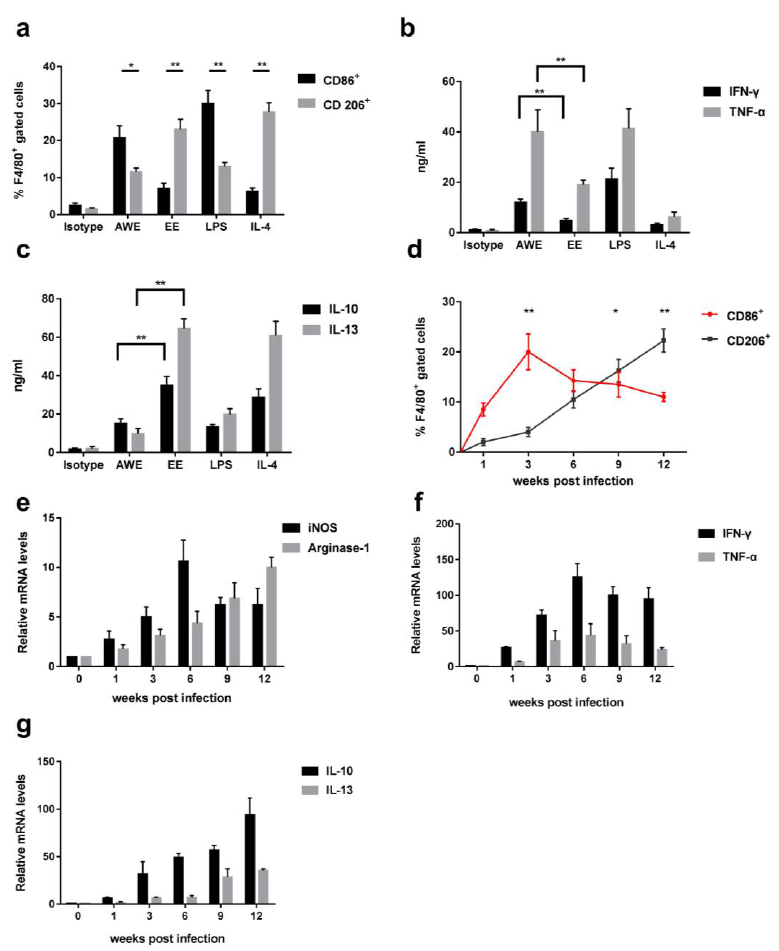
Figure 1. C. hepatica infection induced macrophage polarization in livers of infected mice: ( a ) Macrophages collected from livers of normal mice were incubated in vitro with C. hepatica AWE or EE, which induced M1 (F4/80 + CD86 + ) and M2 (F4/80 + CD206 + ) phenotypes, as measured by flow cytometry, respectively. Isotype antibody was used as negative control; LPS or IL-4 co-cultured with macrophages as M1 and M2 positive controls, respectively. ( b ) The levels of M1-related cytokines IFN- γ and TNF - α were measured in the supernatant of normal mouse hepatic macrophages incubated with AWE or EE by ELISA. ( c ) The M2-related cytokines IL-10 and IL-13 were measured in the supernatant of normal hepatic macrophages incubated with AWE and EE of C. hepatica by ELISA. ( d ) Macrophage polarization from M1 (CD86 + ) to M2 (CD206 + ) on gated F4/80 + intrahepatic macrophage cells during the natural course of C. hepatica infection in mice. ( e ) iNOS (M1) and Arginase-1 (M2) dynamic mRNA expression in macrophages collected from livers of mice infected with C. hepatica measured by RT- qPCR relative to the expression of β -actin (control gene). ( f ) M1-related IFN- γ and TNF - α dynamic mRNA exp ression in the intrahepatic macrophages from C. hepatica -infected mice. ( g ) M2-related IL-10 and IL-13 dynamic mRNA expression in the intrahepatic macrophages from C. hepatica -infected mice. Data are expressed as mean ± SEM from three independent experiments ( n = 5 mice per group). * p < 0.05, ** p < 0.01.